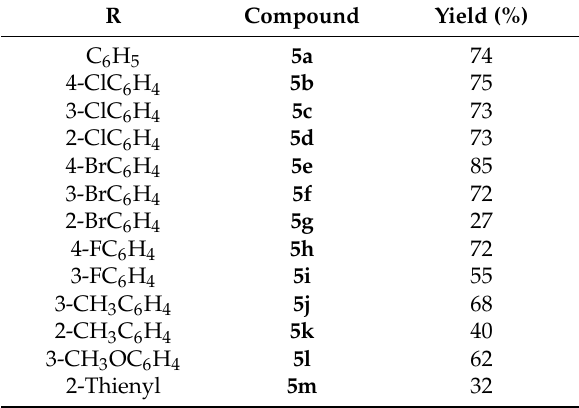
Table 2. Formation of benzo[6,7][1,5]diazocine[2,1- a ]isoindol-12(14 H )-ones 5a – 5m .